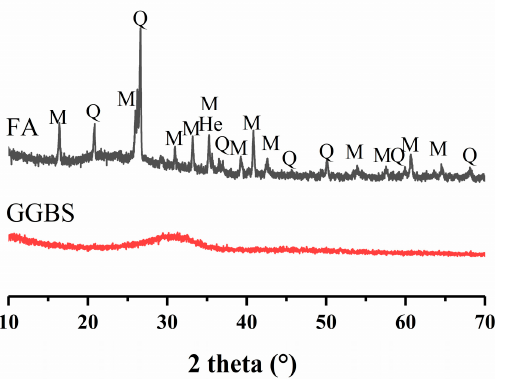
Figure 2. XRD pa tt erns of precursors. Legend: Q = quar tz ; M = mullite; He = hematite. Figure 2. XRD patterns of precursors. Legend: Q = quartz; M = mullite; He =